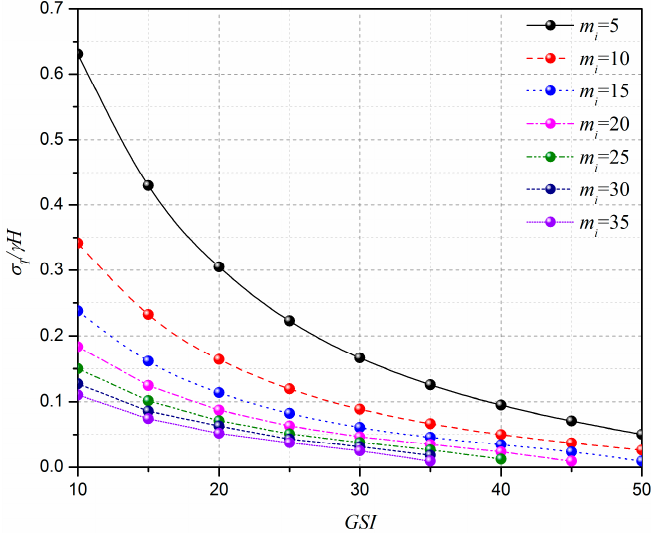
Figure 8. Effect of GSI on the normalized limit support pressure, σ T / γ H.